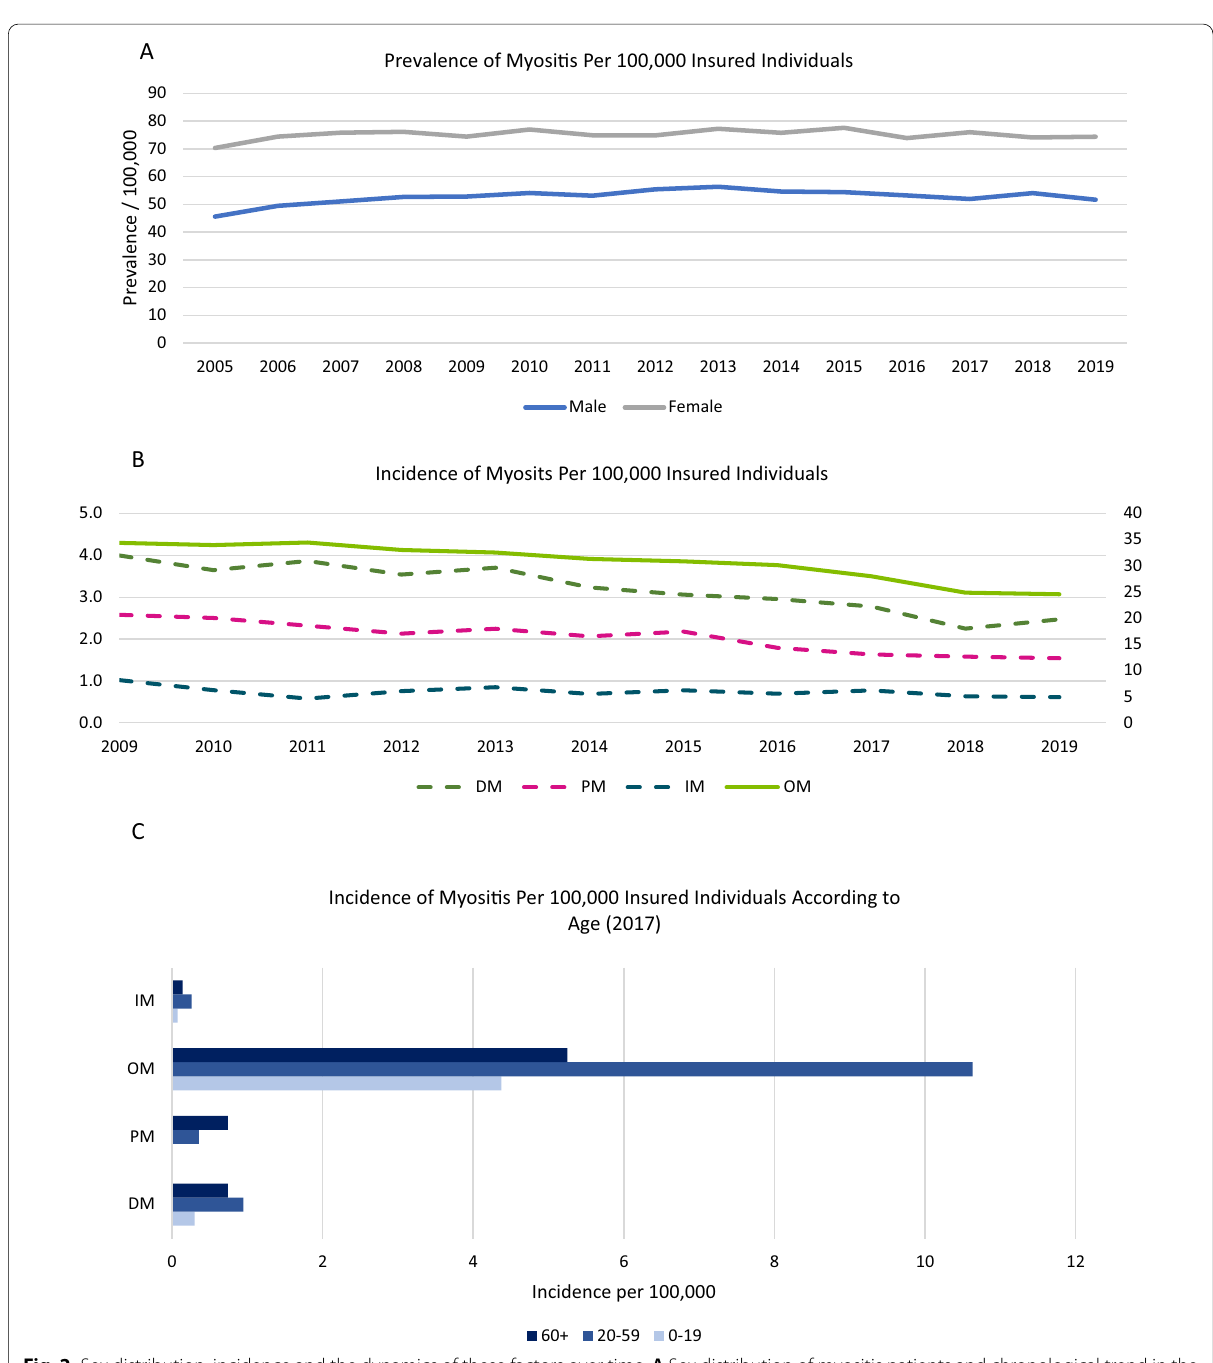
Fig. 2 Sex distribution, incidence and the dynamics of these factors over time. A Sex distribution of myositis patients and chronological trend in the observation period from 2005 to 2019 per 100,000 insured persons. B Incidences of the myositis subgroups and trend over time per 100,000 insured persons. Left Y‑axis: rates of DM, PM, IM; Right Y‑axis: rates of OM. C New cases per 100,000 insured persons, age group and myositis subgroup. DM dermatomyositis, IM interstitial myositis, PM polymyositis, OM other